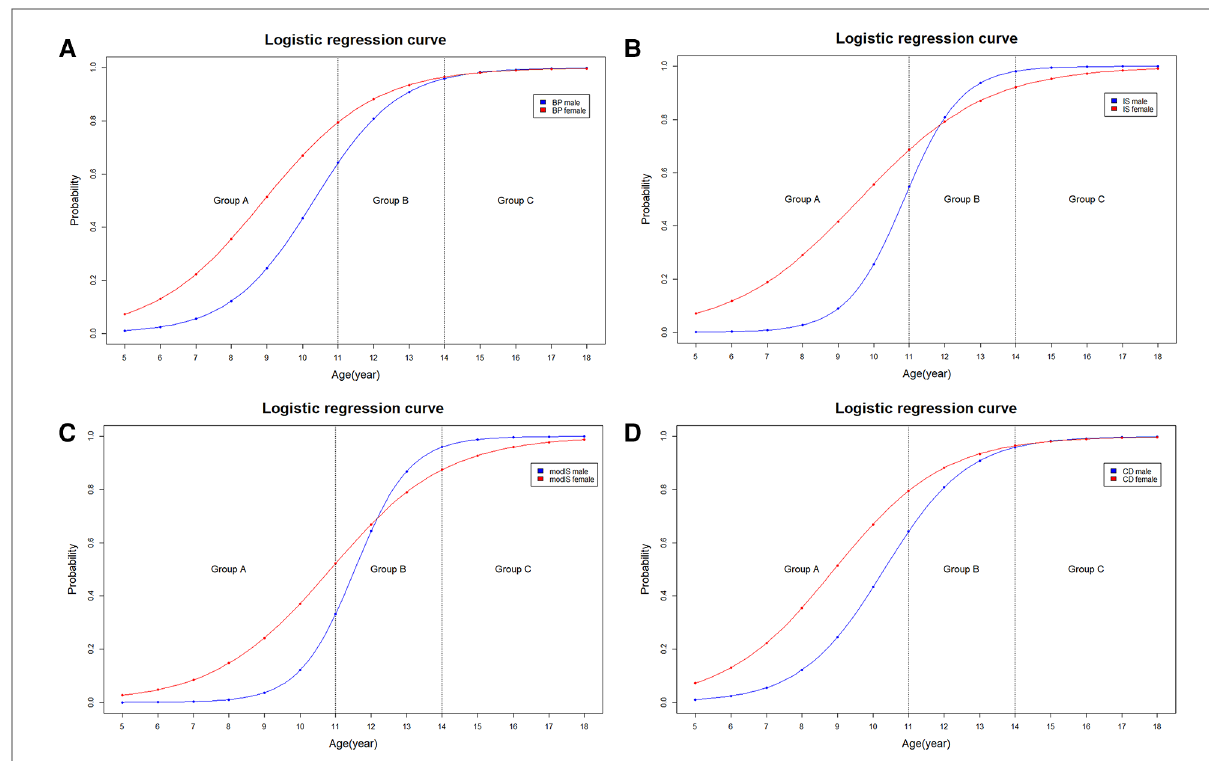
FIGURE 3 Logistic regression curve of the applicable probability between Male and female regarding ( A ) Blackburne-Peel, ( B ) Insall-Salvati, ( C ) modi fi ed Insall- Salvati, ( D ) Caton-Deschamps